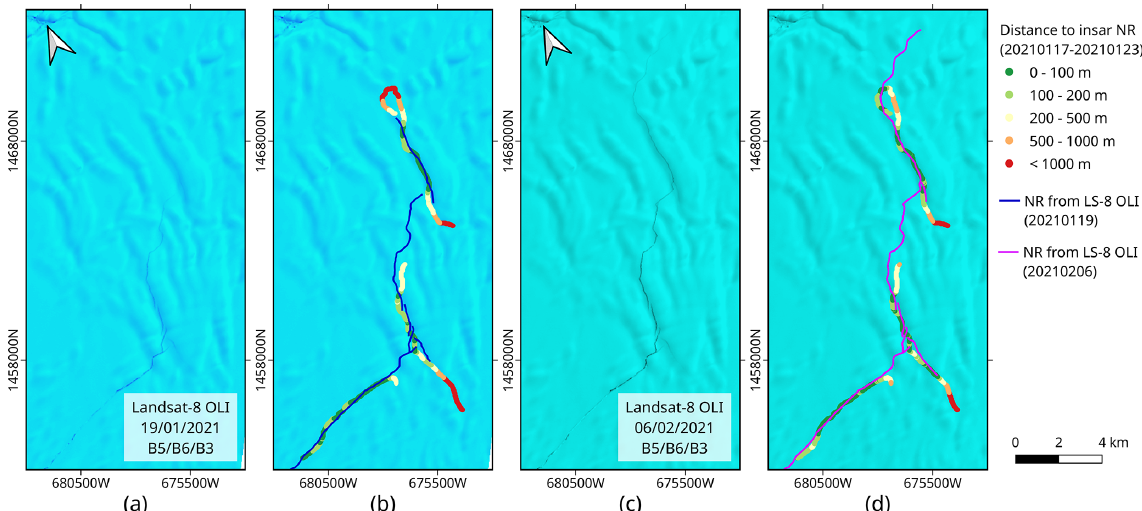
Figure 12. Tip of the North Rift observed with Landsat 8 OLI RGB composites from bands 5, 6 and 3. The composites are overlaid with the North Rift extent manually delineated from the Landsat image and compared with the S-1 InSAR-based North Rift of 17–23 January 2021, colour-coded to represent the distance to the location in the Landsat image. (a) Landsat 8 composite of 19 January 2021. (b) Distance between the North Rift detected with InSAR on 17–23 January 2021 and the North Rift delineated from Landsat 8 on 19 January 2021 (blue). (c) Landsat 8 composite of 6 February 2021. (d) Distance between the North Rift detected with InSAR on 17–23 January 2021 and the North Rift delineated from Landsat 8 on 6 February 2021